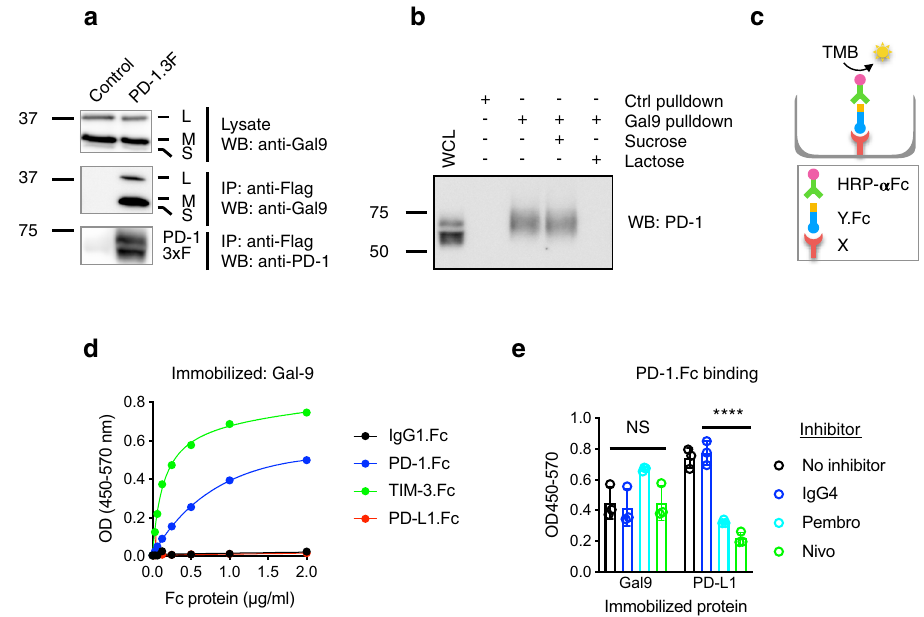
Fig. 1 Galectin-9 is a PD-1-binding protein. a Lysates of Jurkat cells transduced with control lentivirus or PD-1 tagged at the C-terminus with 3× FLAG tag (PD-1.3F) were immunoprecipitated with anti-FLAG magnetic beads and the associated proteins were subjected to immunoblotting with Gal-9 or PD-1 antibodies. The three Gal-9 bands (L, M, S) represent different isoforms resulted from alternative pre-mRNA splicing. b Jurkat PD-1 cell lysates were incubated with glutathione-Sepharose (control) or Gal-9-Sepharose beads with or without sucrose or lactose. Bound proteins were eluted and western blotted with anti-PD-1 antibody. c , d Plate-based binding assay with puri fi ed recombinant proteins shows direct and speci fi c binding of PD-1 extracellular domain (ECD) to Gal-9. MaxiSorp plates were coated with Gal-9 and incubated with Fc-fusion protein of the ECD of test binding partners (PD-1, PD-L1, or TIM-3) at various concentrations. Binding was detected by spectrophotometry using an HRP-labeled anti-human IgG (Fc-speci fi c) antibody and the HRP substrate TMB (3,3 ’ ,5.5 ’ -tetramethylbenzidine). X: protein immobilized on plate; Y.Fc: Fc conjugated potential binding protein or IgG1-Fc (control); HRP- α Fc: HRP (horseradish peroxidase)-labeled anti-Fc antibody. e Binding of PD-1 ECD to immobilized Gal-9 or PD-L1 ECD in the absence or presence of the PD-1 antibodies pembrolizumab (Pembro) or nivolumab (Nivo). n = 3 independent experiments. Error bars represent SD. Statistical differences were assessed using two-way ANOVA with Sidak ’ s multiple comparisons test. IgG4 vs Nivo, P < 0.0001; IgG4 vs Pembro, P < 0.0001. Data are representative of three ( a , b ) or two ( d ) independent experiments. Source data are provided as a Source data fi